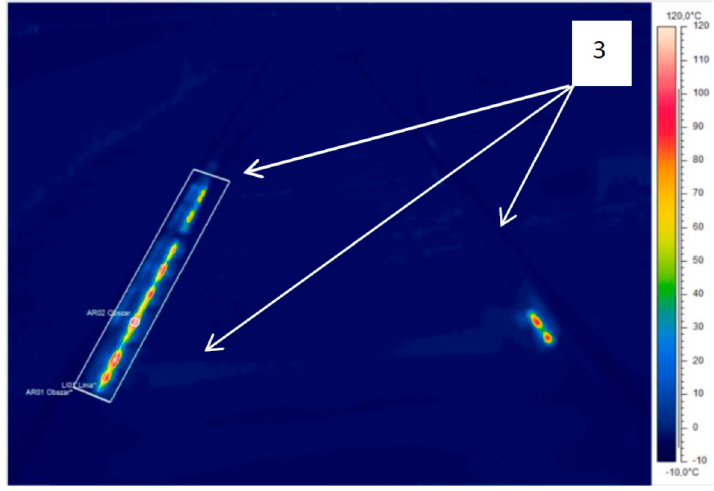
Figure 12. Thermogram IR_0145, rain900 colour palette, span correction from − 10 °C to 120 °C (source: authors).